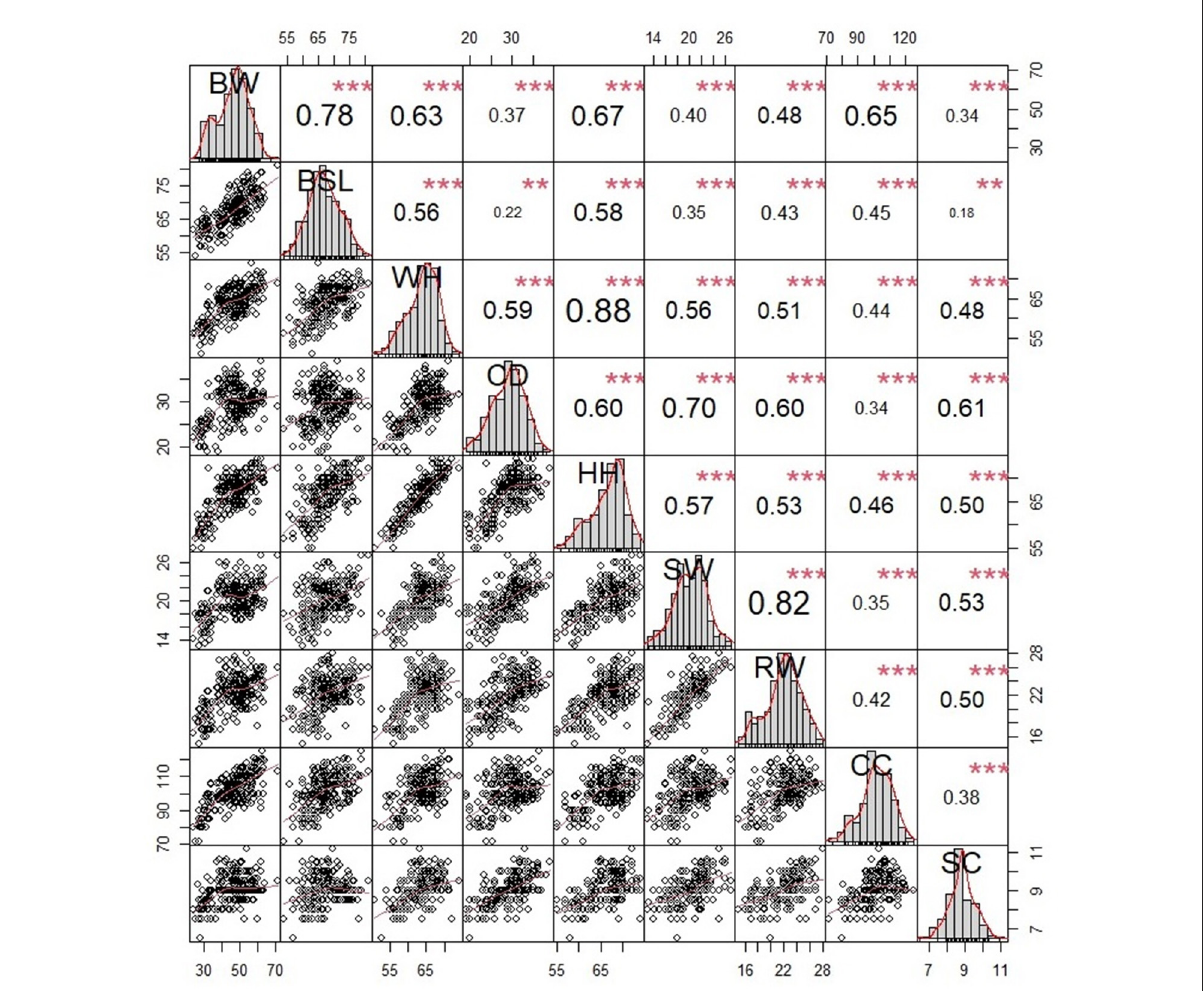
FIGURE3 Analysis diagram of the ewe’s Spearman correlation. Scatter plots are shown in the lower left corner, correlation-significance plots between traits are shown in the upper right corner, and the data distribution map is shown in the middle. BW, body weight; HW, height at wither; BSL, body slanting length; CD, chest depth; CC, chest circumference; SC, shank circumference; HH, hip height; SW, shoulder width; RW, pump width. *p < 0.05, **p < 0.01, ***p <